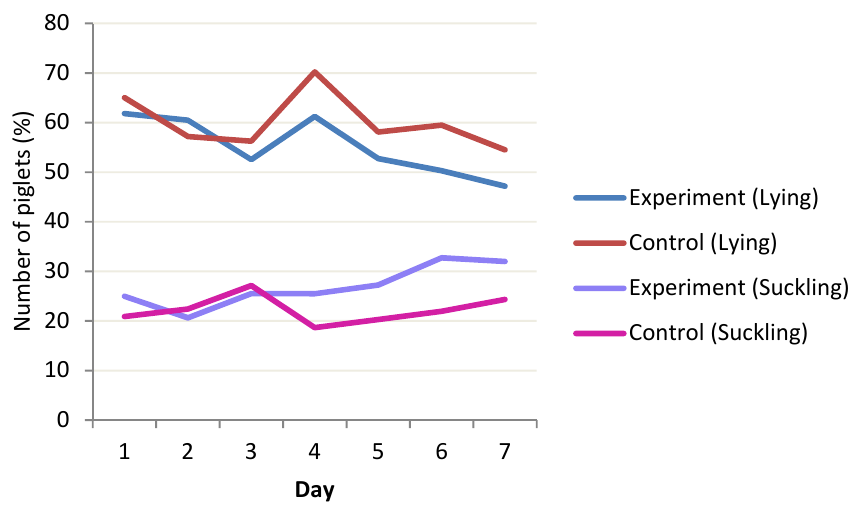
Figure 3. Mean percentage of lying and suckling piglets per litter in the experimental and control groups over seven days (days 1–3 = before vaccination, day 4 = day of vaccination, and days 5–7 = after vaccination).